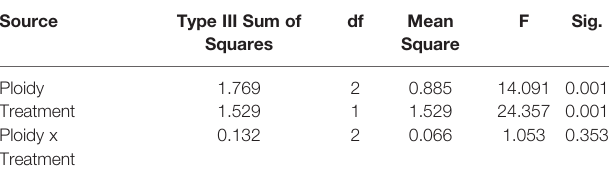
TABLE 1 | P-values for the two way ANOVAs to determine the interaction effect of stress treatment and ploidy level on the proportion of sexual ovules. Source Type III Sum of Squares